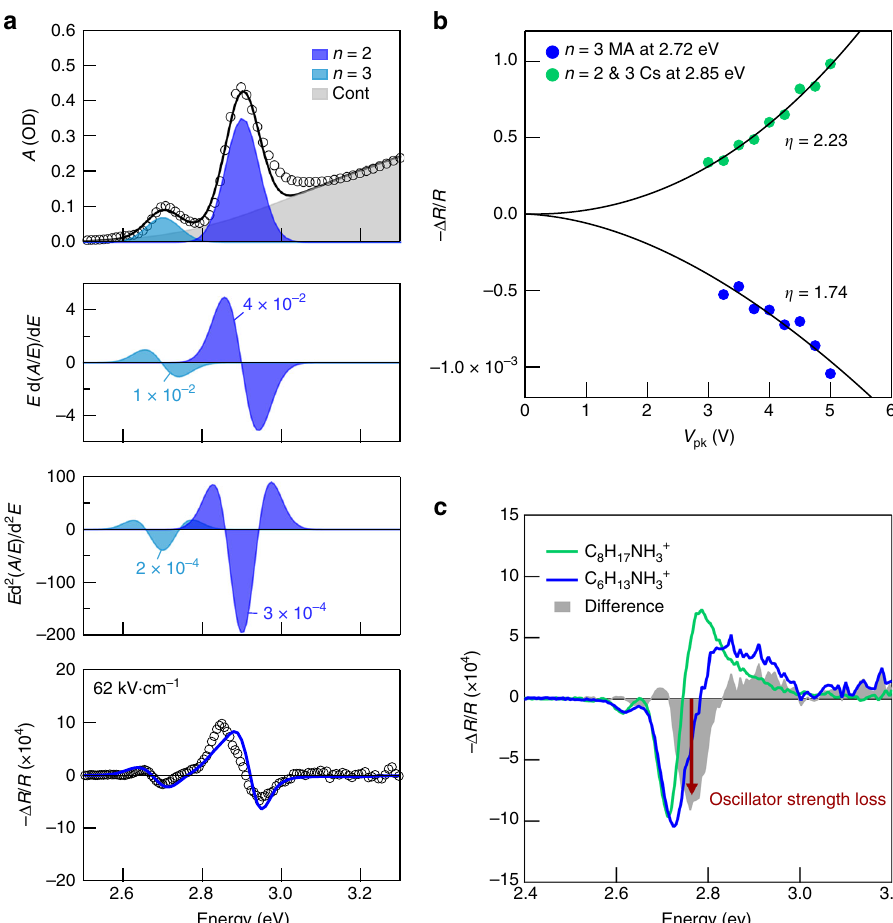
Fig. 3 Cation tuning of the QCSE. a Electroabsorption spectrum for perovskite nanoplatelets with cesium cations. From top to bottom: optical absorption pro fi le and fi t, fi rst-derivative of excitonic optical absorption, second-derivative of excitonic optical absorption, electroabsorption spectrum. Open circles indicate experimental data points. Electric fi eld strength indicates that applied to the nanoplatelet layers. b Nonlinear dependence of the QCSE on electric fi eld. Solid lines correspond to a power law fi t de fi ned by parameter η . The cesium and methylammonium-based nanoplatelets display opposing re fl ectance changes at their electroabsorption extrema. c Electroabsorption spectra for n = 3 methylammonium nanoplatelets with hexylammonium and octylammonium ligands. The difference between the spectra is provided and primarily shows a change in oscillator